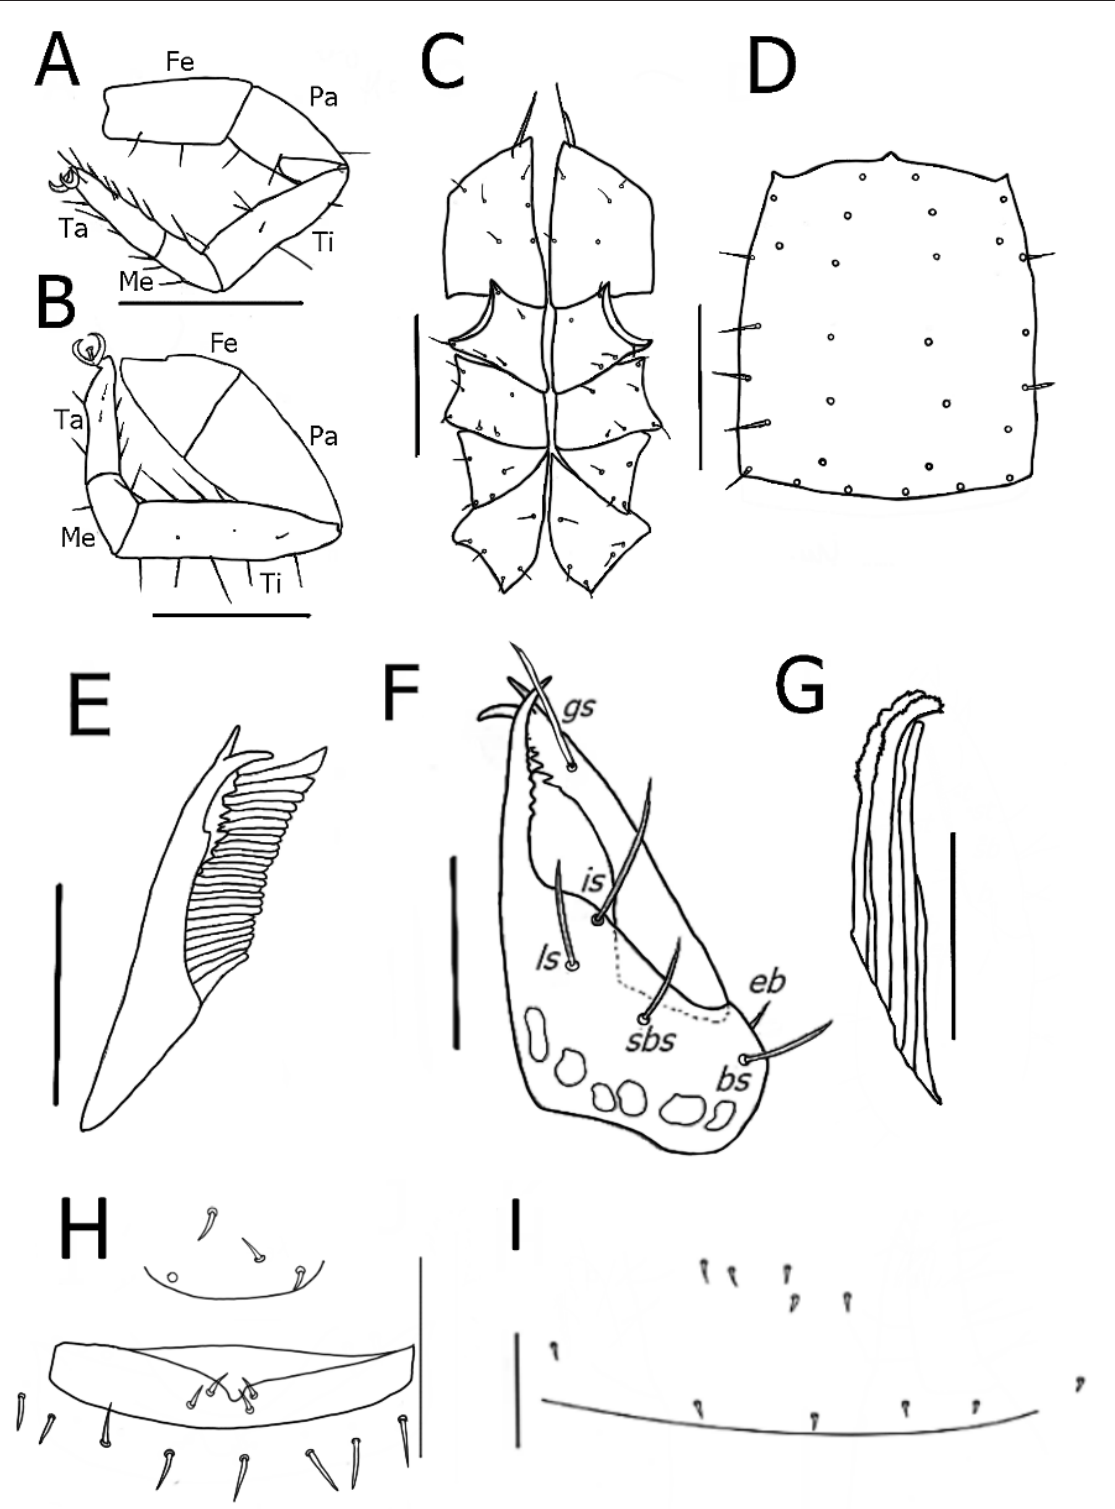
Fig. 29. Ideoblothrus safinai sp. nov. A . Leg I. B . Leg IV. C . Coxa. D . Carapace. E . Galea and serrula exterior. F . Chelicera, with trichobothria. G . Rallum. H . Genitalia. I . Genitalia. A–F, H: holotype, ♂ (QCAZ); G: paratype, ♂ (ZMH A0015394); I: allotype, ♀ (QCAZ). Abbreviations: Fe = femur; Pa = patella; Ti = tibia; Me = metatarsus; Ta = tarsus. Scale bars: A–B, E = 0.50 mm; C–D = 0.25 mm; F = 0.125 mm; G = 40 µm; H = 18 µm; I = 36